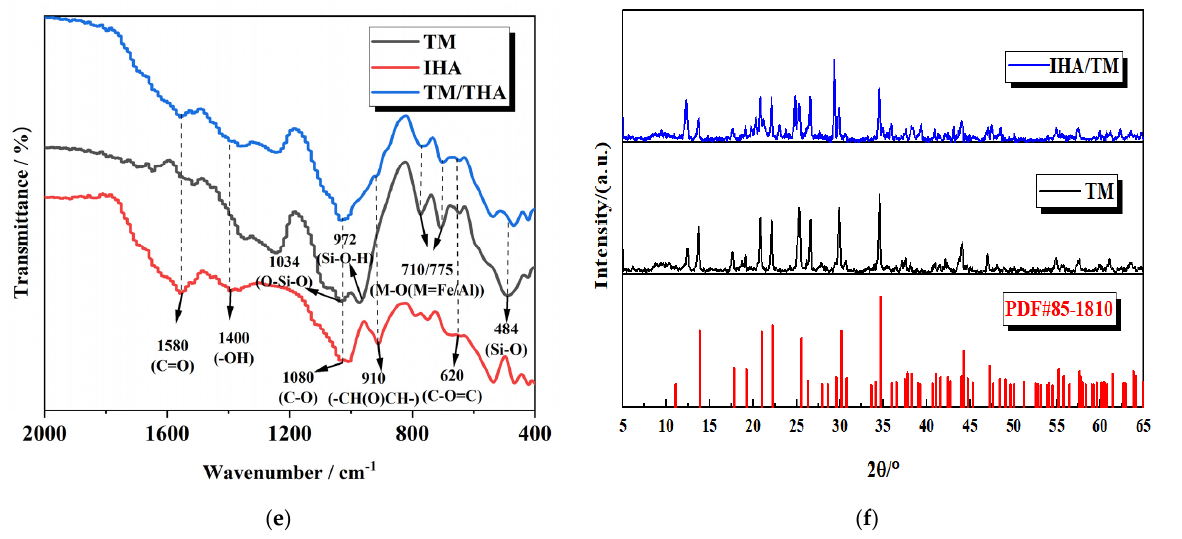
Figure 6. Micro analysis. ( a ) N 2 adsorption–desorption isotherms of TM and IHA/TM; ( b ) SEM images of TM and IHA; ( c ) SEM images of IHA/TM; ( d ) EDS spectra of IHA/TM; ( e ) FTIR spectra of IHA/TM; and ( f ) XRD patterns of IHA/TM.